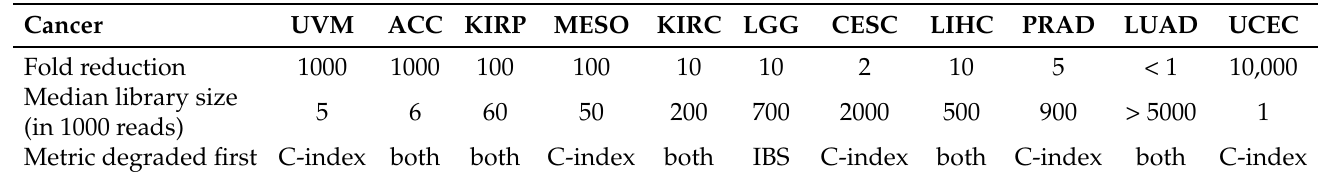
Table 3. Maximum mRNA-seq library size reduction before the decreasing of prediction performance, corresponding median sequencing depth (in thousands of aligned reads), and prediction metric degraded first, for the Cox model, and the 11 investigated cancers.